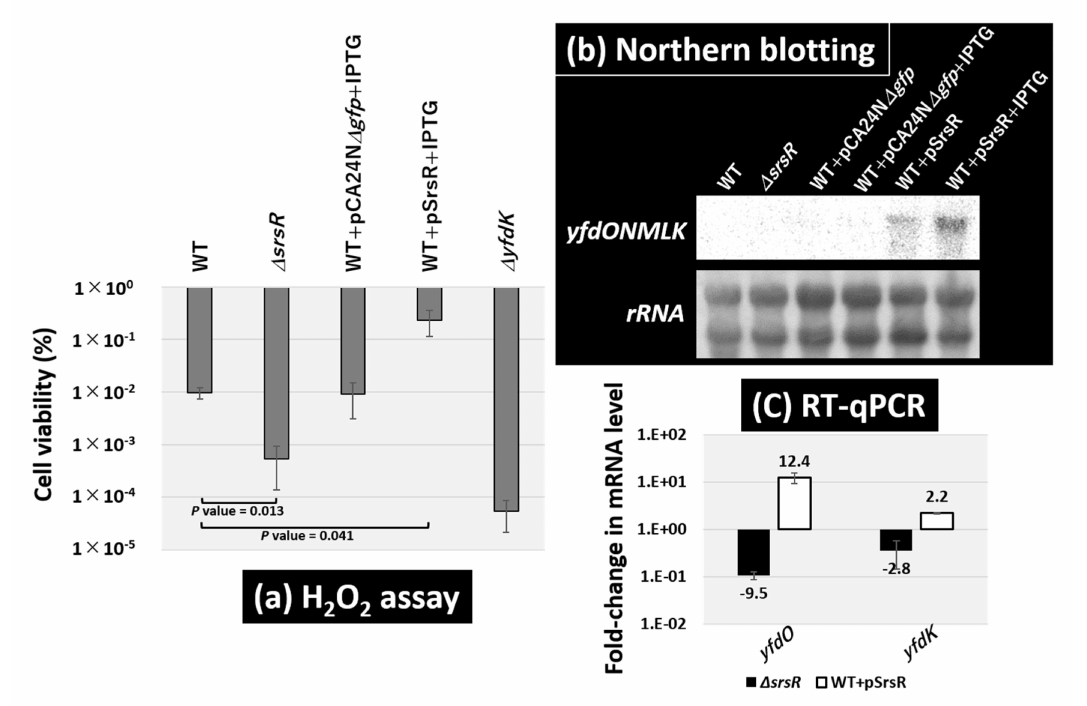
Figure 7. Sensitivity test against hydrogen peroxide. ( a ) Survival test for the E. coli wild-type BW25113, its srsR -deleted mutant JW5476, the wild-type strain harboring SrsR overexpression vector, its empty vector, and yfdK mutant JW2350. Each strain was inoculated until the OD 600 reached 0.4 (exponential phase) and then subjected to 30 mM H 2 O 2 for 15 min. The relative level of sensitivity represents the mean ± SD of three experiments. Statistically significant differences were obtained using the Student’s t-test with multiple comparisons’ correction and are represented by line under bars with associated p values. ( b ) E. coli wild-type BW25113 and its srsR -deleted mutant JW5476, the wild-type strain harboring its empty vector, and SrsR overexpression vector with or without IPTG were grown in an LB medium at 37 ◦ C until the OD 600 reached 0.4 (exponential phase). Total RNA was prepared from both wild-type and the srsR mutant and subjected to Northern blot analysis. The mRNA of the yfdONMLK transcription unit detected with yfdK DIG-labeled hybridization probes is shown. The amounts of total RNA analyzed were examined by measuring the intensity of ribosomal RNAs. ( c ) The same RNAs as in panel ( b ) were subjected to RT-qPCR analysis. The y -axis represents the relative level of mRNA of yfdO and yfdK between the wild-type and the srsR mutant (black bar) as well the relative level between the wild-type harboring SrsR overexpression vector and empty vector (white bar); the ratio of 16S rRNA was set as an internal control between the compared strains. Each experiment was repeated at least three times, and the average means are